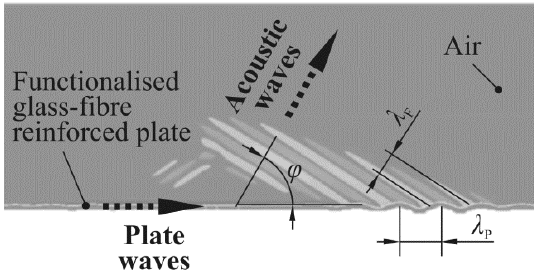
Figure 1. Radiation of the ultrasound wave from the functionalized Textile-reinforced thermoplastic composites (TRTC) plate at an angle φ . composites (TRTC) plate at an angle ϕ